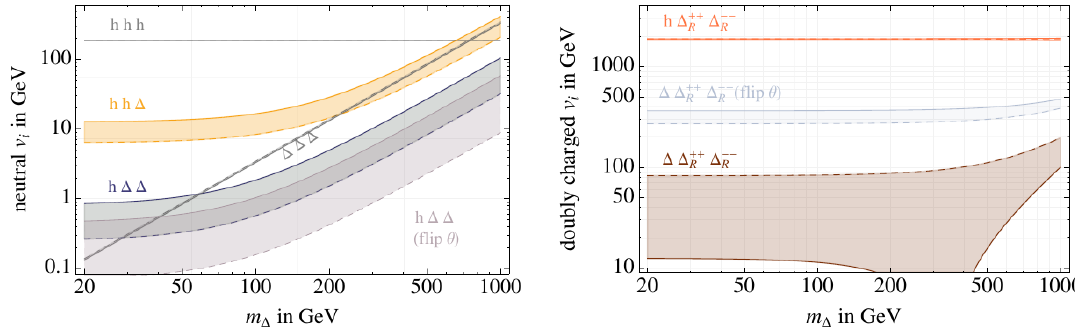
Figure 10 . Left: tree-level neutral tri-linear Higgs couplings from eqs. (A.4){(A.7) with regions covering the s (cid:18) 2 (0 : 05 ; 0 : 1) interval and M W = 4 TeV. Right: tri-linear vertices with doubly R charged scalars. The pink region shows the v vertex that enters the (cid:13)(cid:13) and Z(cid:13) rates and (cid:1)(cid:1) ++ R (cid:1) (cid:0)(cid:0) R m = 1 TeV, m H = 17 TeV was taken in agreement with BB and h ! (cid:13)(cid:13) bound, discussed (cid:1) ++ R in [57], that comes from the v coupling. h (cid:1) ++ R (cid:1) (cid:0)(cid:0) R other parameters such as (cid:11) and (cid:21) disappears. The numerical value of these vertices is 2 i plotted on the left panel of (cid:12)gure